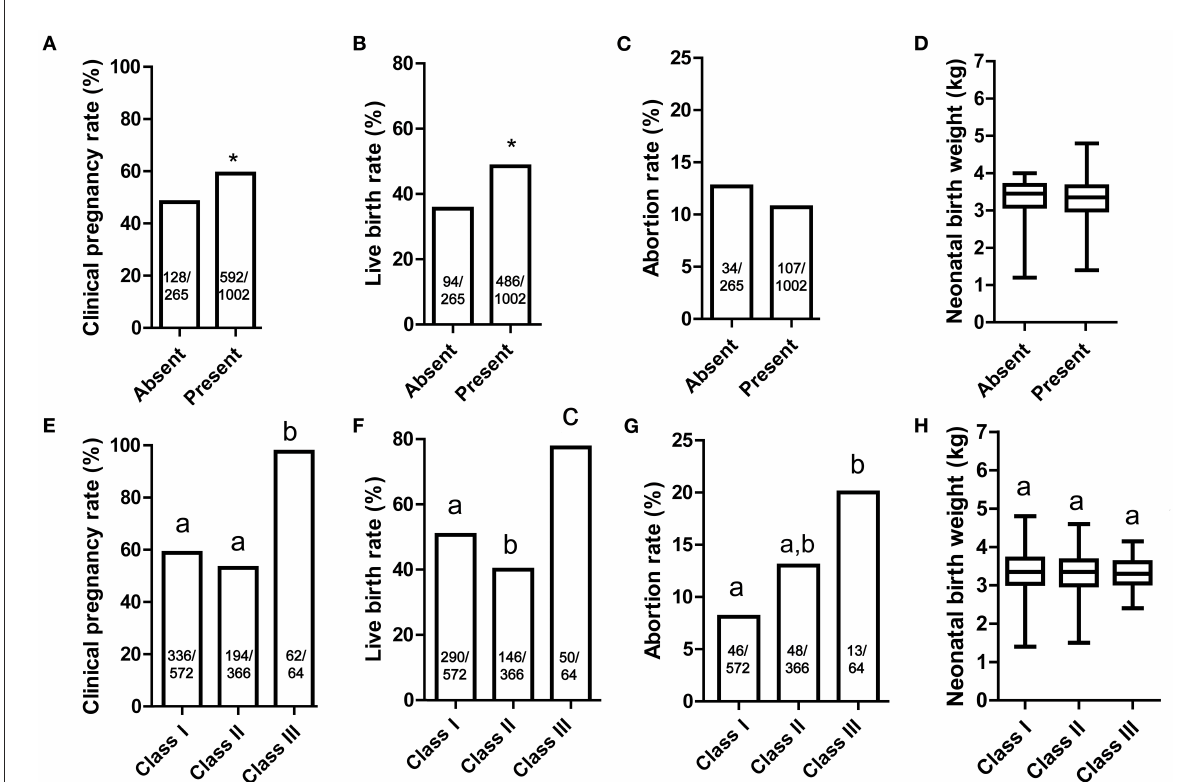
FIGURE4 The outcomes of blastocyst with cytoplasmic strings between ICM and mTE cells. (A) Clinical pregnancy rate of Absent and Present groups; (B) live birth rate of Absent and Present groups; (C) abortion rate of Absent and Present groups; (D) neonatal birth weight of Absent and Present groups; (E) clinical pregnancy rate of Class I, II and III groups; (F) live birth rate of Class I, II and III groups; (G) abortion rate of Class I, II and III groups; (H) neonatal birth weight of Class I, II and III groups. (A–D) Absent group was compared with Present group, and significant differences (Chi-square test and Mann-Whitney U test, P < 0.05) are indicated by * . (E–H) Same superscript lowercase letters indicated no statistical differences in the intergroup comparisons (multiple Chi-square test and Kruskal-Wallis test followed by Dunn’s test for multiple comparisons, P > 0.05). ICM, inner cell mass; mTE, mural trophectoderm. The sample size was presented on each